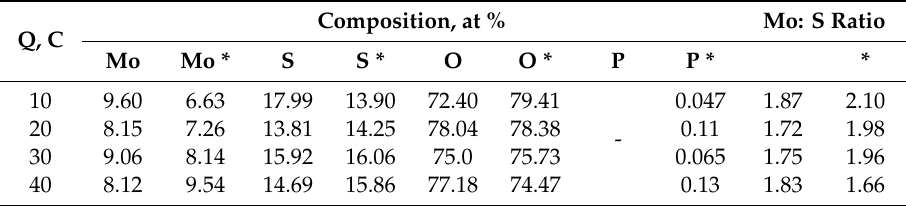
Table 1. Dependence of chemical composition of MoS 2 films on the passed charge at a cathodic current of 10 mA; films electrodeposited from electrolytes containing MoS 42 − , and MoS 42 − + NaH 2 PO 2 (denoted with *). Composition, at